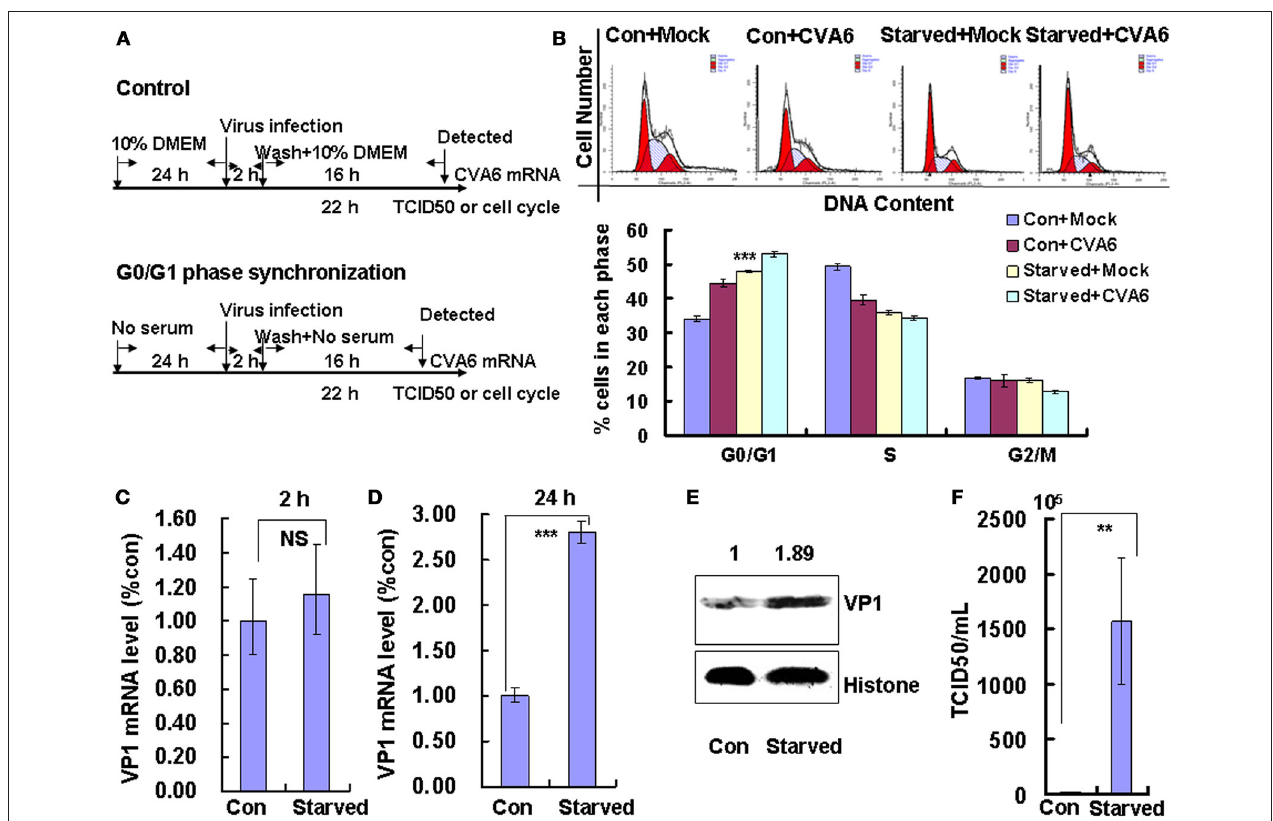
FIGURE 2 | G0/G1 phase-synchronization promotes viral replication. (A) RD cells were cultured in serum-free medium for 24h for G0/G1-phase synchronization. Infected with mock (Mock) or infected with CVA6 (CVA6) at an MOI of 1 for 2h, then the medium was restored to maintain the cell cycle synchronization status for 24h. (B) Top panel: Flow cytometry determined the cell cycle profiles after culture in control medium (Con) or serum-free medium (Starved) and mock-infection or infection with CVA6. Bottom panel: The histograms indicating cell cycle distribution were analyzed by the ModFit LT program. *** P < 0.001 (Starved + Mock vs. Con + Mock). (C,D) Intracellular CVA6 RNA levels were detected by quantitative real-time PCR in RD cells that were cultured in control (Con) or serum-free medium (Starved) at 2h (C) or 18h (D) post-infection with CVA6. The results were standardized using GAPDH mRNA as a control and normalized to 1.0 in the Con cells.